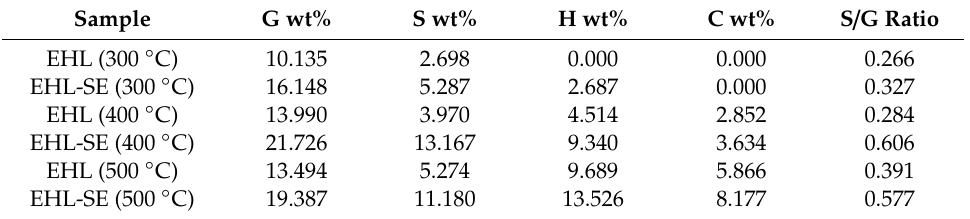
Table 3. Proportion of G, S, H and C of pyrolysis products of di ff erent samples and S / G ratio determined with Py-GC / MS.